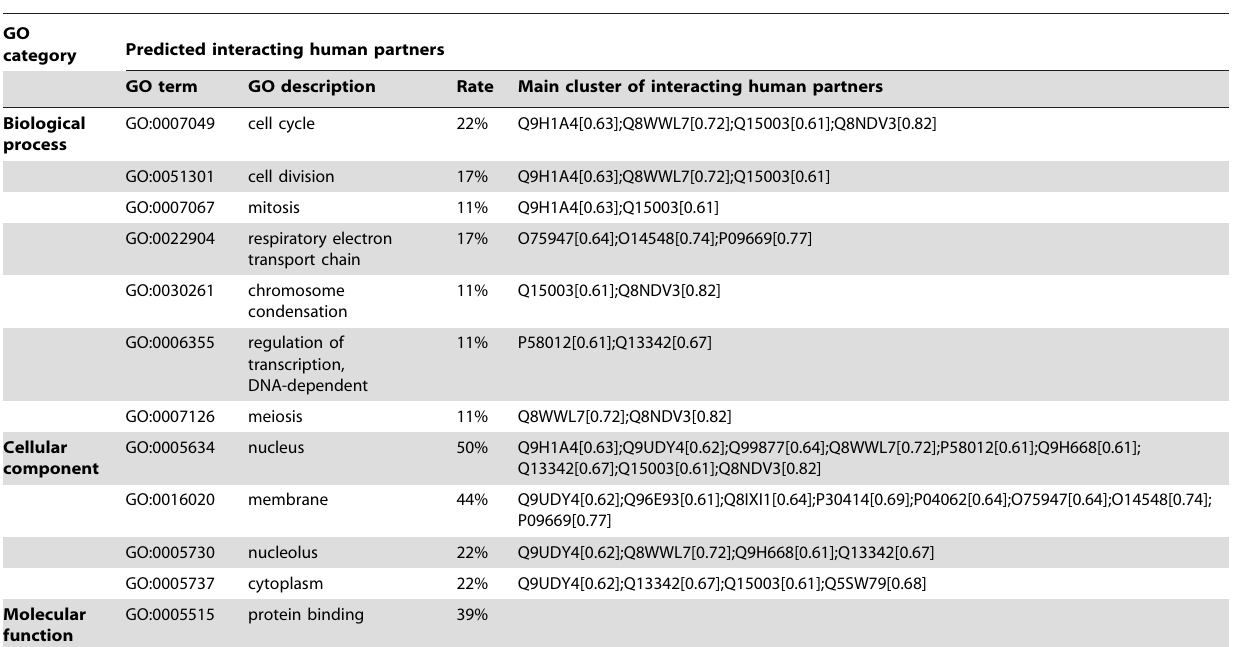
Table 6. Predicted interactions between Vpr and human